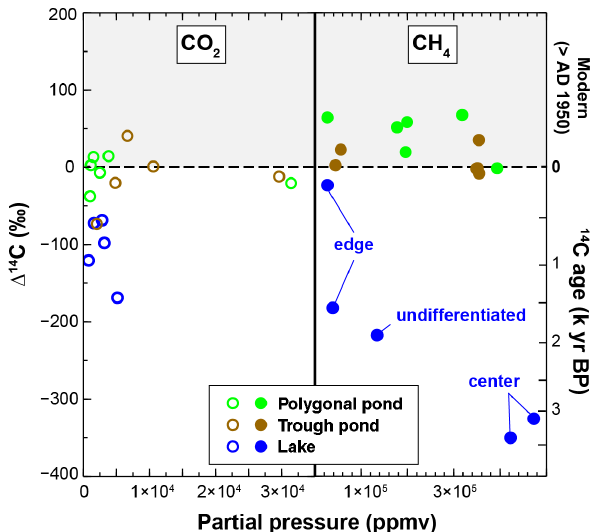
Figure 5. Concentration and age of ebullition GHG collected from ponds and lakes on Bylot Island, Nunavut. Gas concentration ( x axis) is expressed as partial pressure (in ppmv, parts per million volumetric) of CO 2 (open circles) and CH 4 (full circles). Radiocar- bon age is expressed as the normalized radiocarbon activity ( (cid:49) 14 C, in ‰; left y axis) corrected for isotopic fractionation and decay that took place between sampling and measurement dates, and in thou- sands of years before present (kyr BP; right y axis).